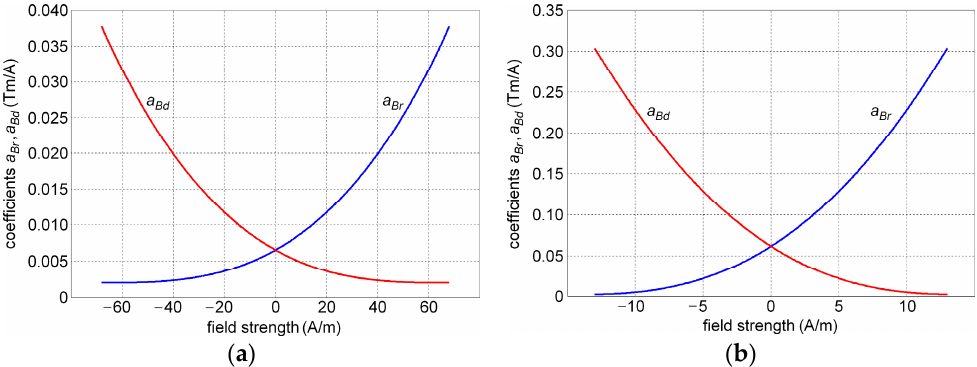
Figure 2. Dependencies of parameters a Br and a Bd on the field strength H 0 for B 0 = 0: ( a ) dynamo sheet M530-50A; ( b ) transformer sheet M120-27S.